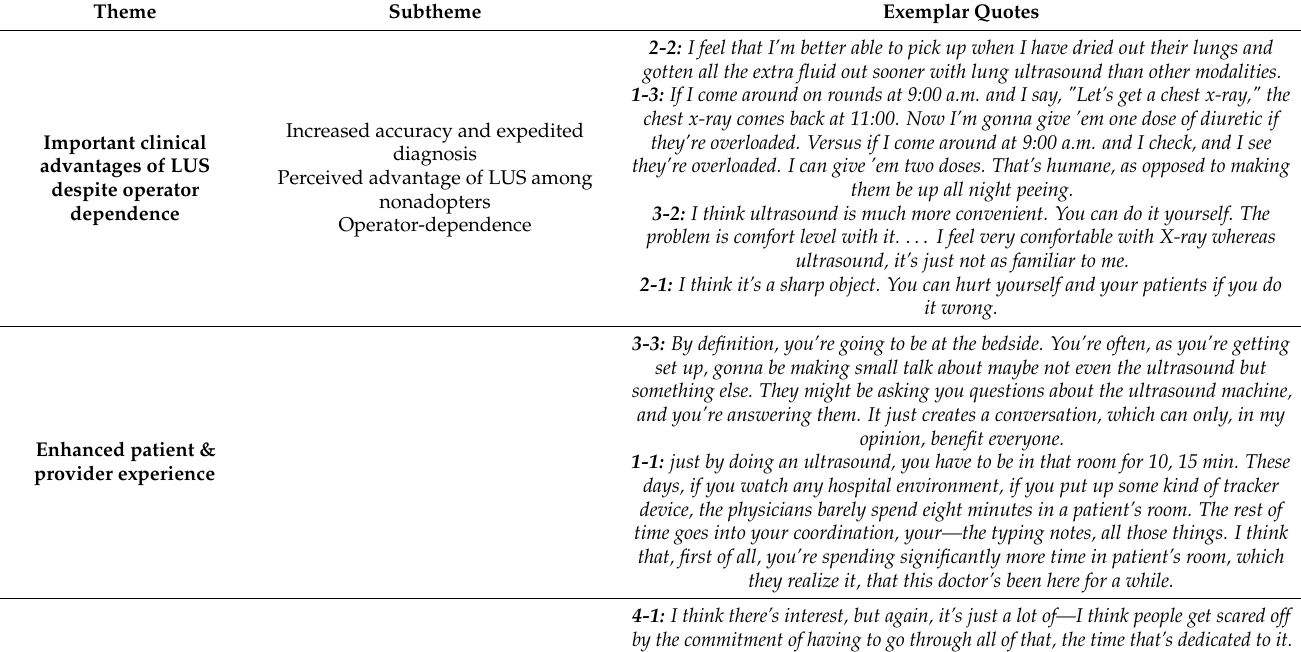
Table 4. Themes and